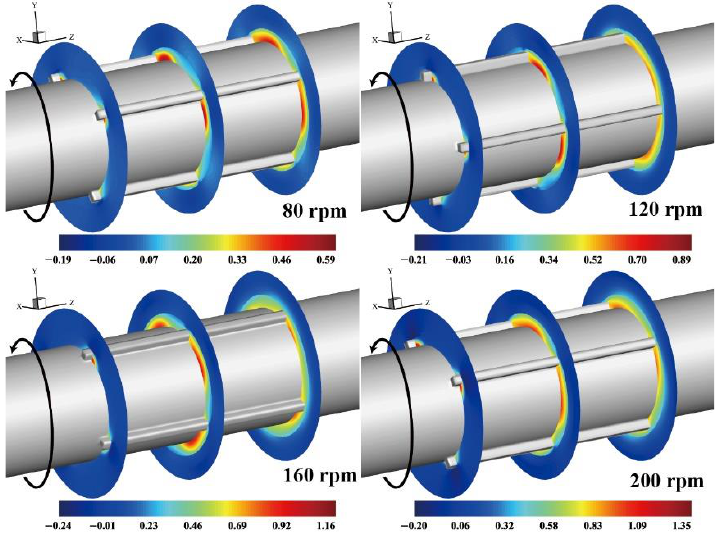
Figure 5. Fluid circumferential velocity distribution at different cross sections of the blade under different rotational speeds ( α = 0°).